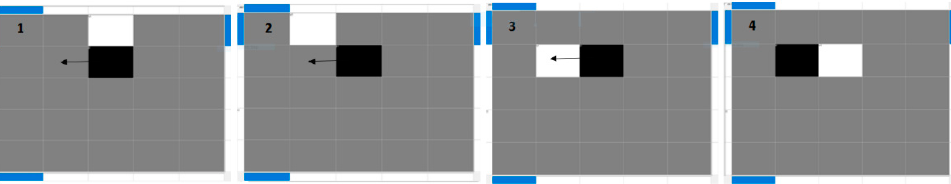
Figure 4. An example of message-passing algorithm.